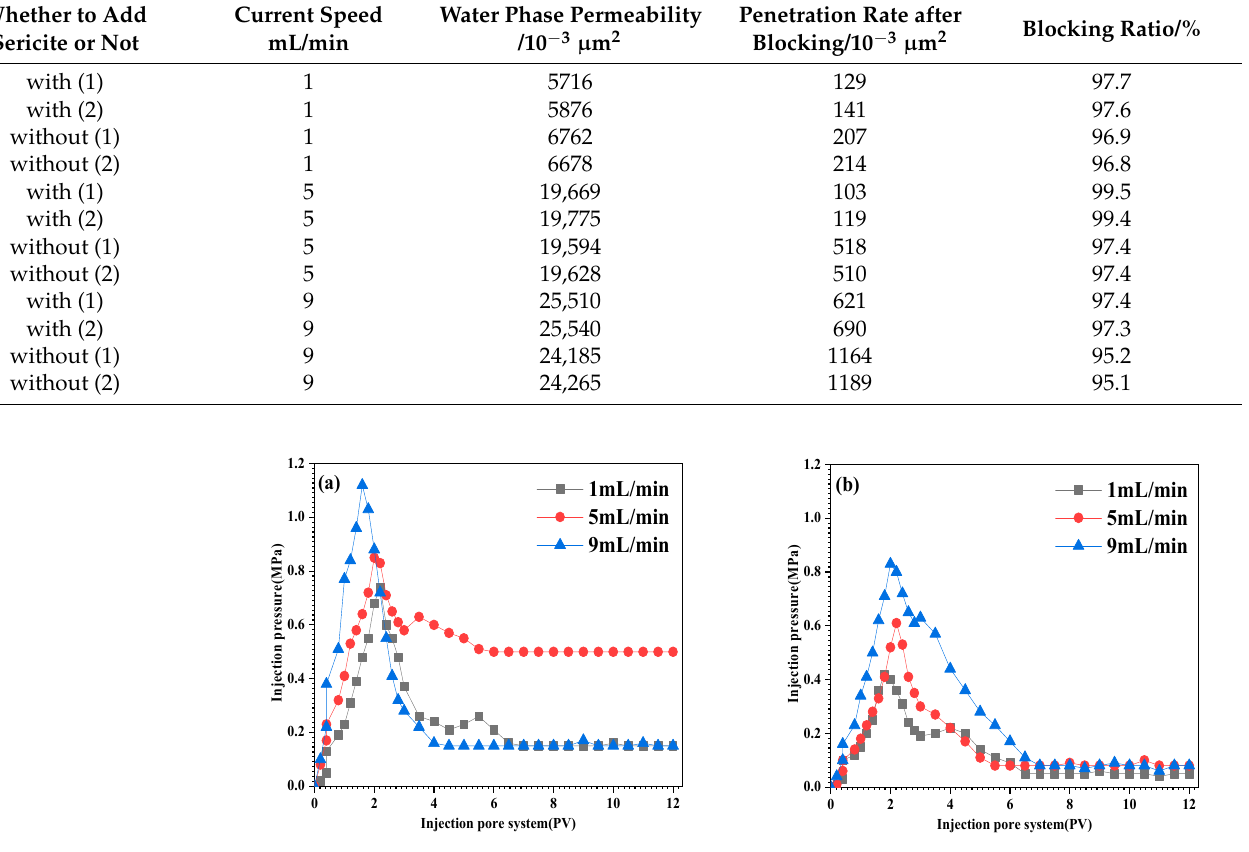
Figure 8. Blocking properties of plugging agent: ( a ) with sericite; ( b ) without sericite. It was found that under different flow rates, the blocking ratio of the plugging agent after adding sericite is effectively improved [37]. When the flow rate is 5 mL/min, the blocking ratio of the plugging agent is the largest. The blocking ratio of the plugging agent without sericite and with sericite is 97.4% and 99.5%, respectively, showing an increase of 2.1% (Table